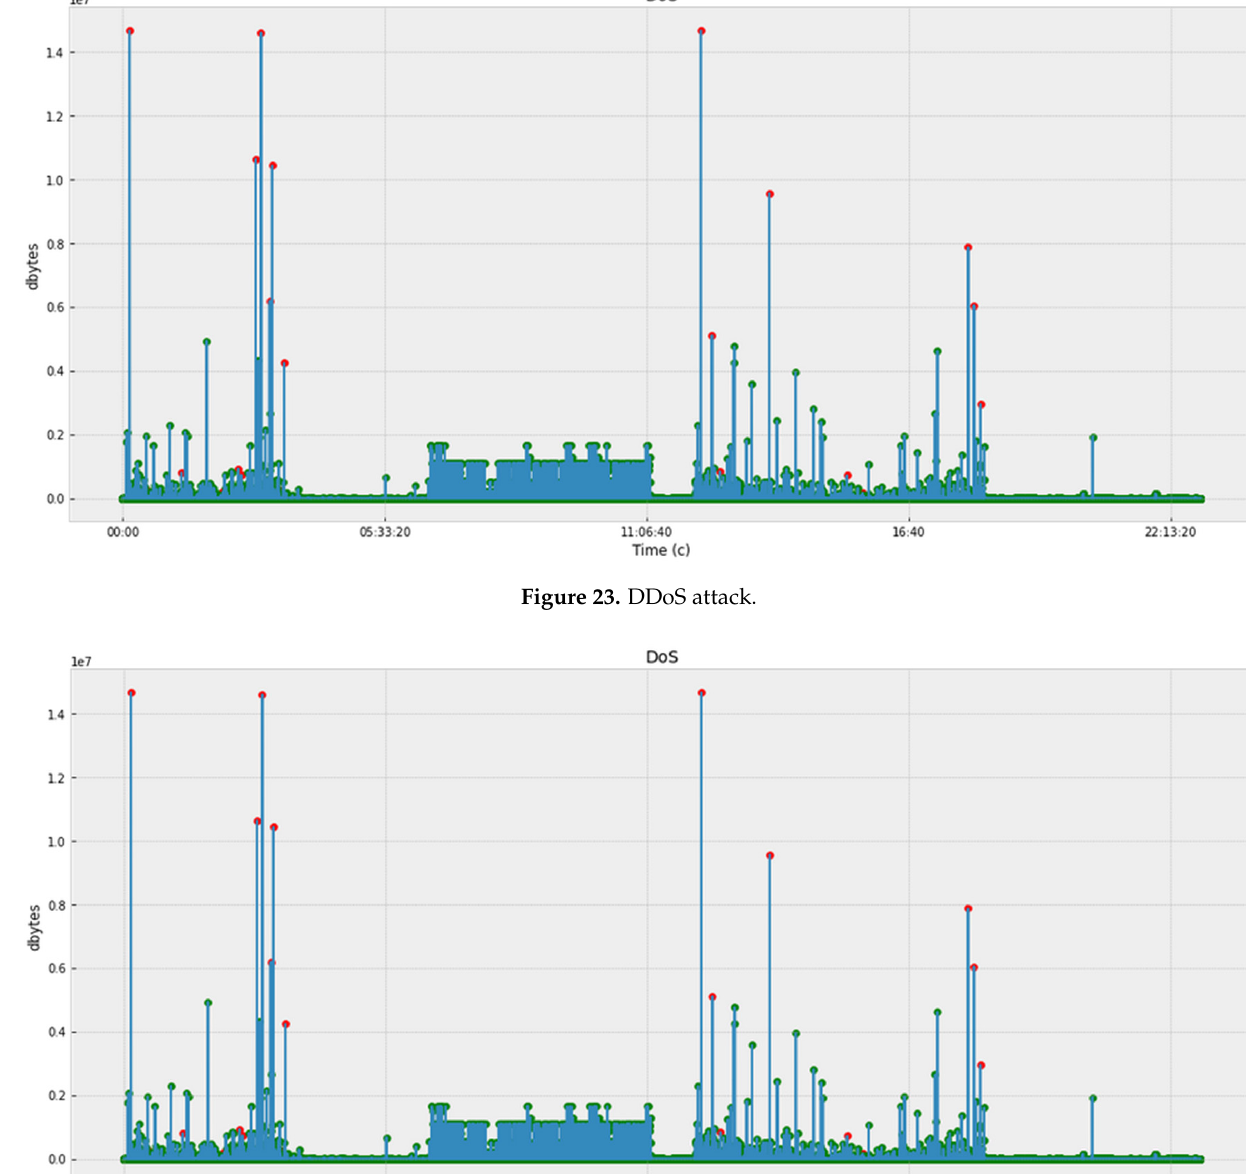
Figure 22. SSH protocol.